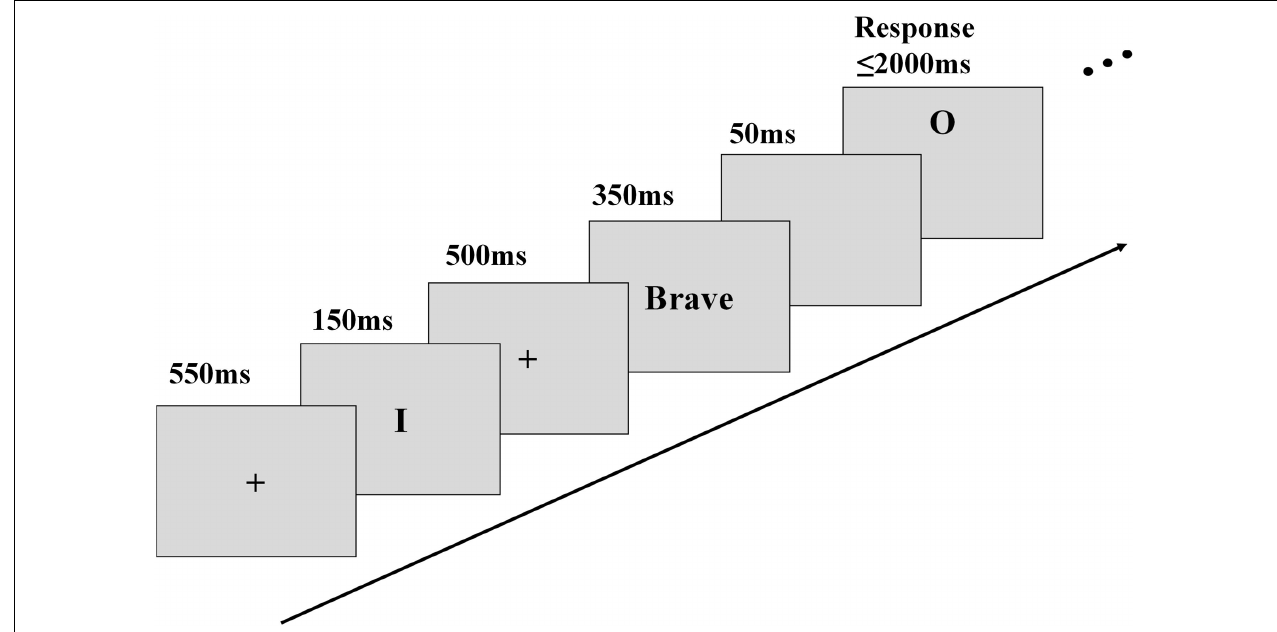
FIGURE 1 | Illustration of experimental procedure of the attention orientation